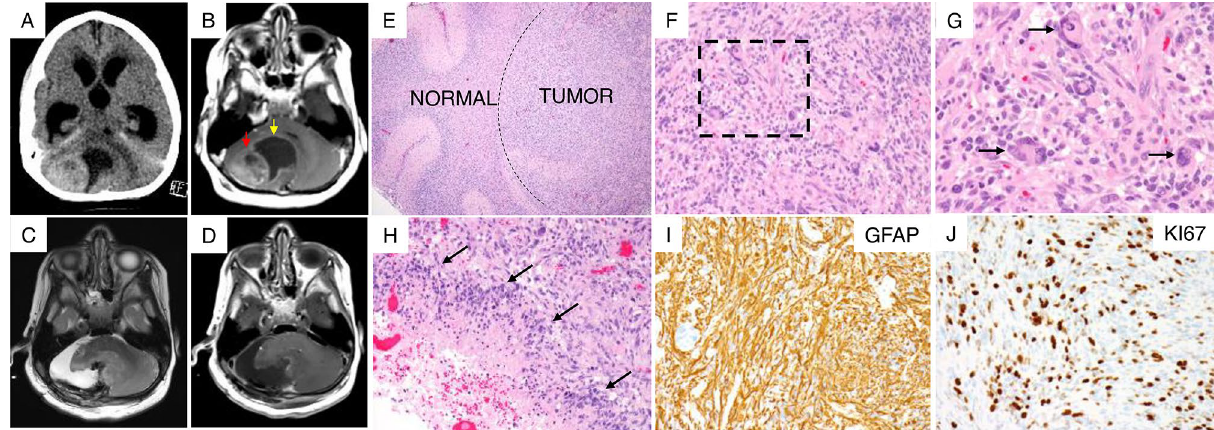
Figure 1. Clinical presentation and tumor histology. ( A ) CT scan of the head demonstrating large cerebellar tumor causing obstructive hydrocephalus. ( B ) T1-weighted MRI scan of the brain with contrast showing a heterogenous lesion (red arrow) alongside large cyst (yellow arrow) within the cerebellum. ( C , D ) T2-weighted ( C ) and T1-contrast enhanced MRI scan ( D ) of the brain post-surgery showing near total resection of the tumor. ( E ) Lower magnification hematoxylin and eosin (H&E) stain of tumor tissue showing expansion and infiltration of normal cerebellum (left) by tumor cells (right). ( F ) Higher magnification H&E stain of tumor demonstrating nuclear pleomorphism (aggressive tumor feature). ( G ) Higher magnification H&E stain (of dashed box in F ) showing nuclear pleomorphism (black arrows). ( H ) The tumor also demonstrates pseudopalisading necrosis (black arrows), a histopathological feature of glioblastoma multiforme. ( I , J ) Immunohistochemistry showing glial origin for tumor based on glial fibrillary acid protein (GFAP) expression ( I ) and a highly proliferative lesion based on approximately > 30–40% Ki-67 antigen expression in tumor cells imaged at medium power ( J